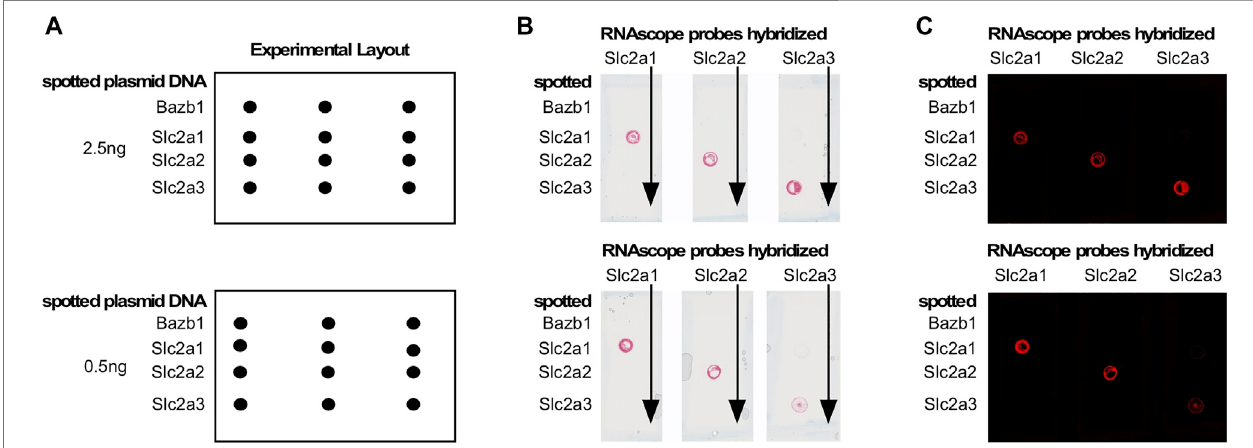
Frontiers in Cell and Developmental Biology |